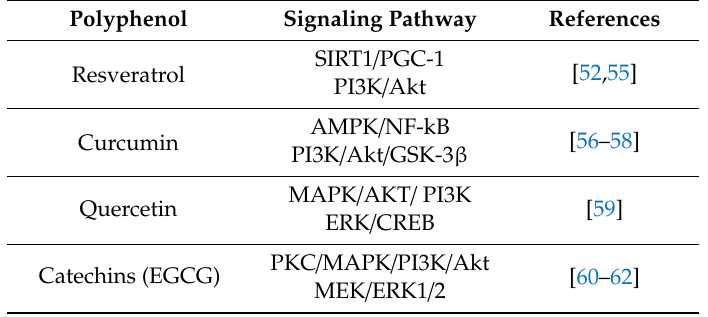
Table 1. Signaling pathways activated by polyphenols in neurodegenerative diseases.